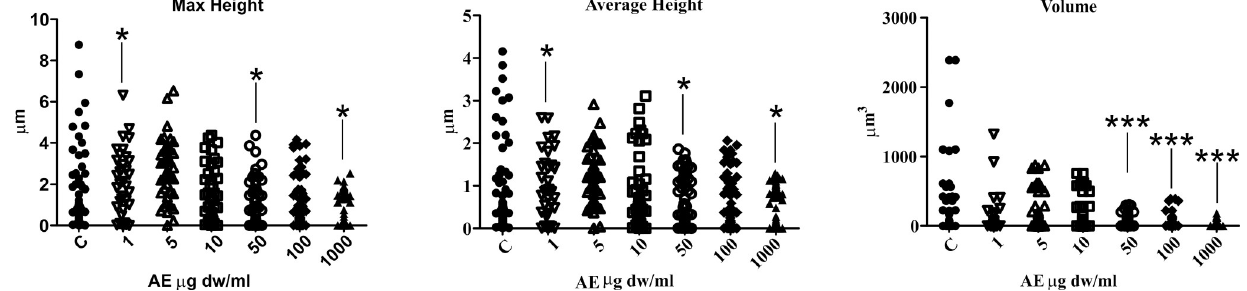
Fig 9. Scatter plots of maximum height, average height and volume obtained by AFM imaging. Dunnett’s multiple comparison test was employed to assess the differences. Only comparisons with control are reported. � P < 0.05; ��� P « 0.01.